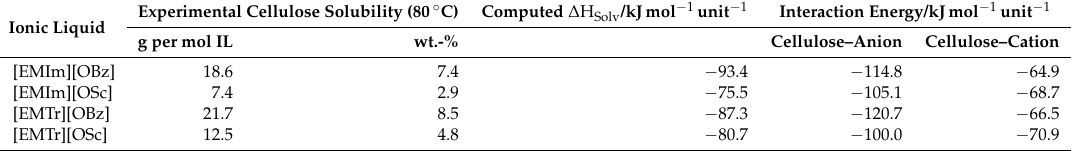
Table 4. Experimentally determined cellulose solubilities at 80 ◦ C (Columns 2 and 3); computed ∆ H Solv per glucose unit (Column 4); contributions of the cellulose–anion and cellulose–cation interaction energies (Columns 5 and